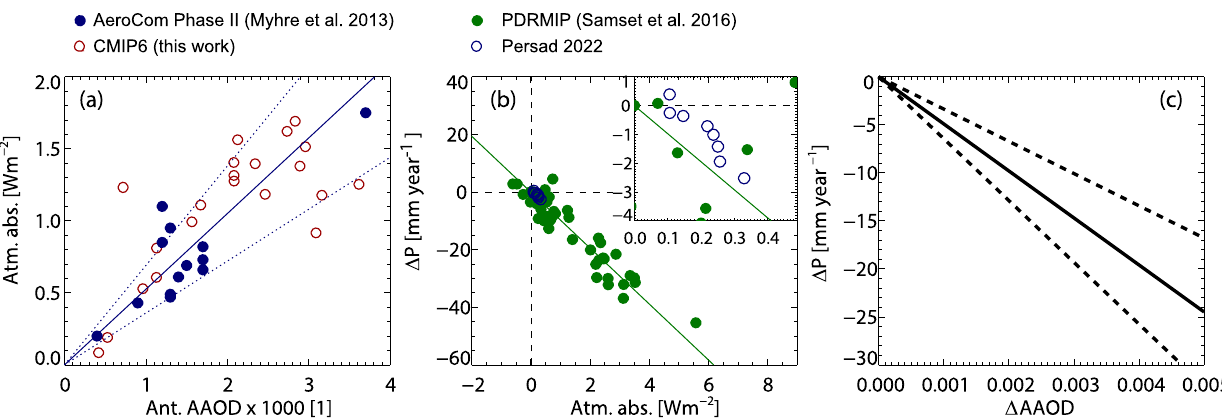
Fig. 2 Emergent relationship between AAOD and precipitation inhibition. a Relation between AAOD change and atmospheric absorption, derived from models participating in AeroCom Phase II and CMIP6. b Relation between atmospheric absorption and precipitation inhibition, from PDRMIP (global perturbations) and Persad 2022 (regional perturbations). c Derived relationship from combining ( a ) and b according to Eq.